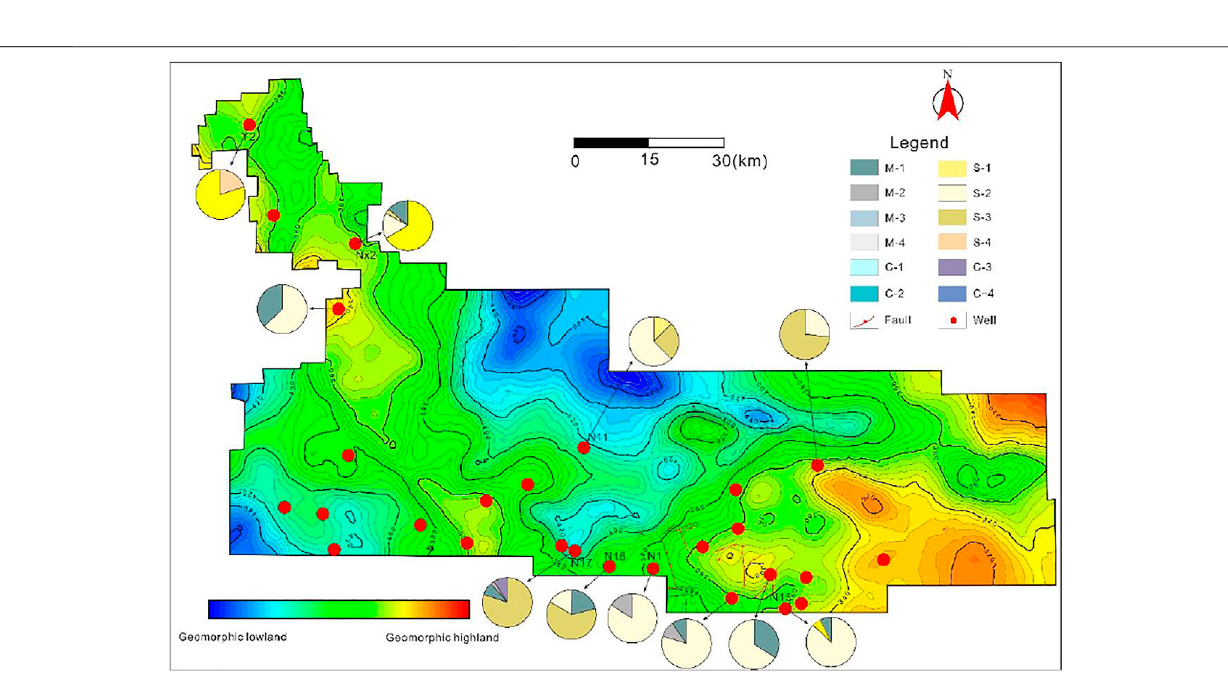
Frontiers in Earth Science |